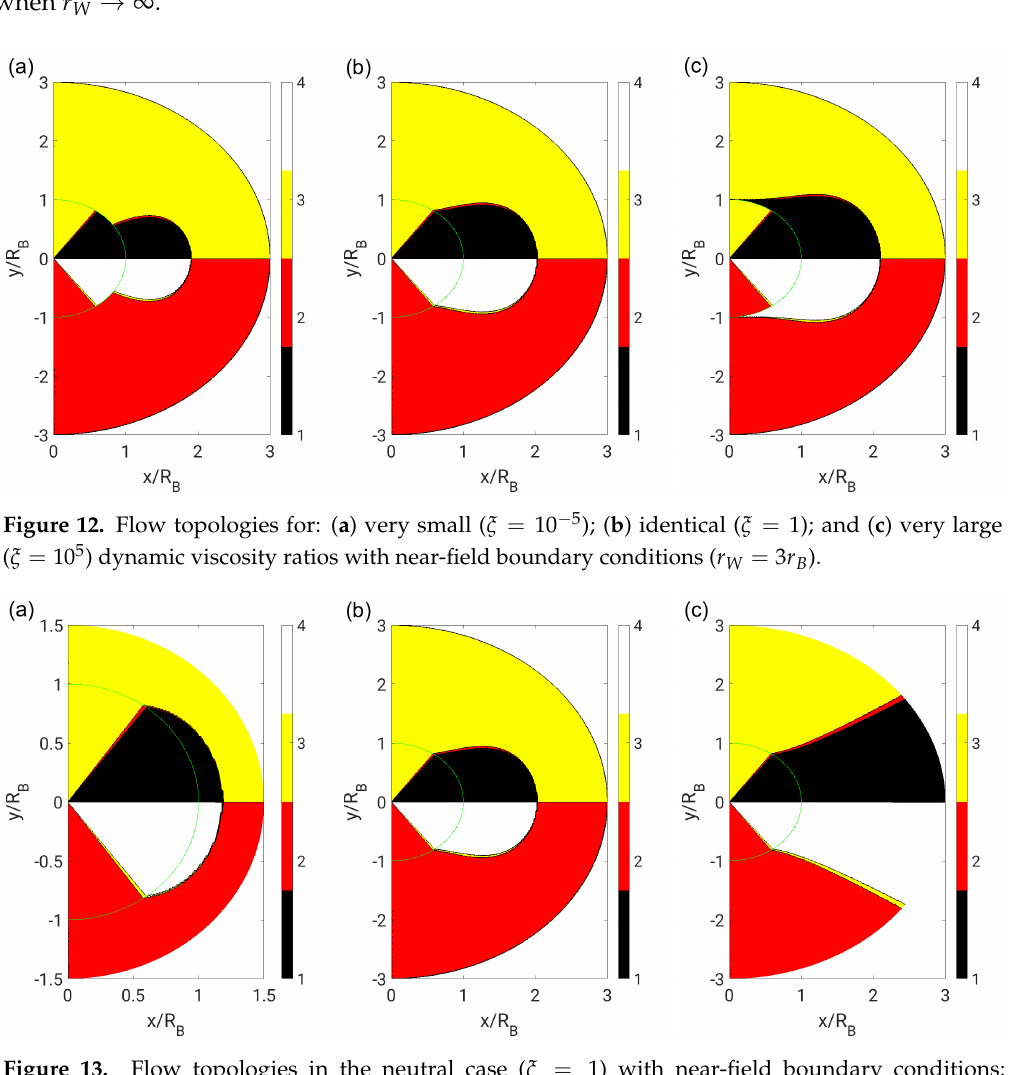
Figure 13. Flow topologies in the neutral case ( ξ = 1) with near-field boundary conditions: ( a ) r W = 1.5 r B ; ( b ) r W = 3 r B ; and ( c ) r W = 100 r B